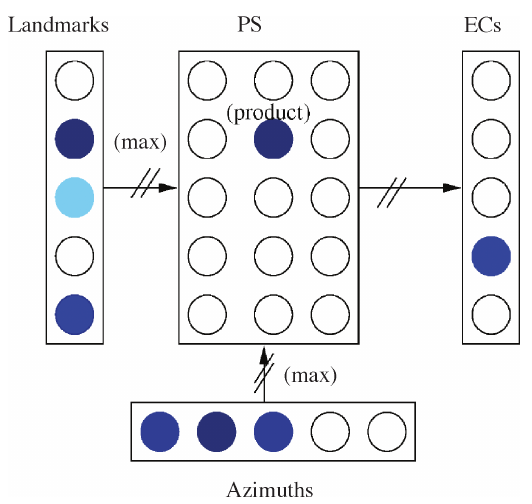
Figure 5. Neural network (ECs) responsible for the PC coding. A neuron of the network learns a particular pattern of activity of PS. This same neuron then fires for this pattern, and for patterns close to it. This determines the place field. Only one winner is shown on ECs, but several other neurons may be